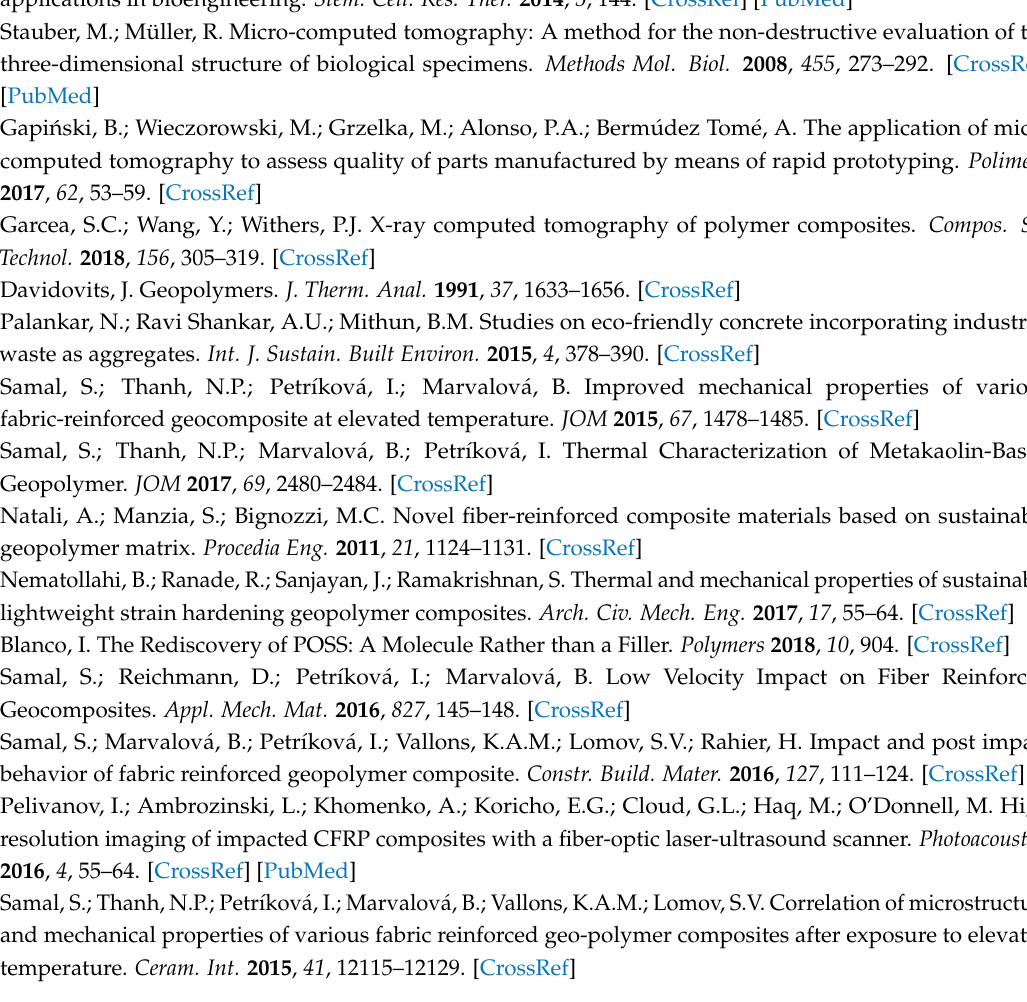
Figure S1: SEM images of E-glass geocomposite after damage, showing matrix rupture, fibre pull out and non-adhesion. Figure S2. SEM images of Basalt reinforced geocomposite after impact test, showing the fiber breakage, matrix cracks, non-adhesion of fabric–matrix interface, Video S1: 3D analysis of basalt fiber from center to edge in basalt fiber reinforced